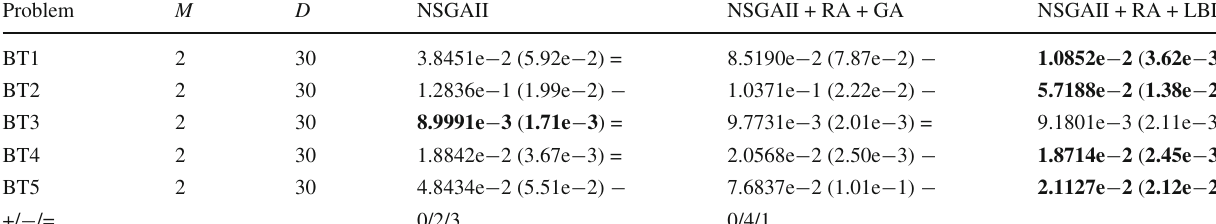
Fig. 8 Sensitivity study on the robust archive